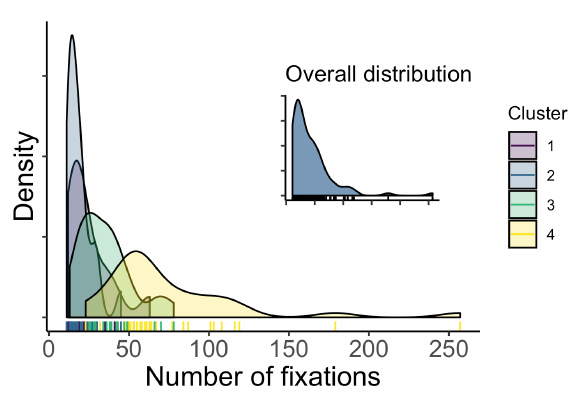
Figure 5. Distribution of fixations of the four clusters.